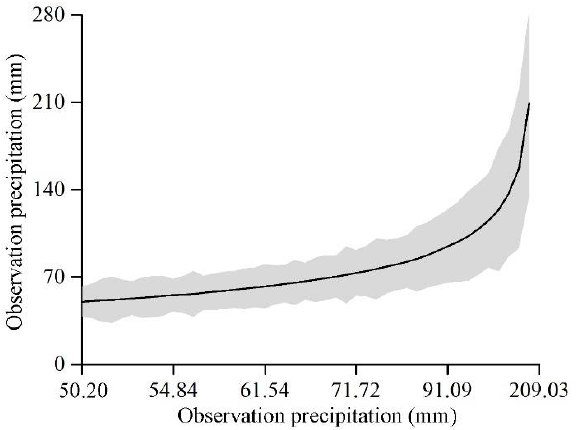
Figure 10. Uncertainty of correction products (gray band represents error range).